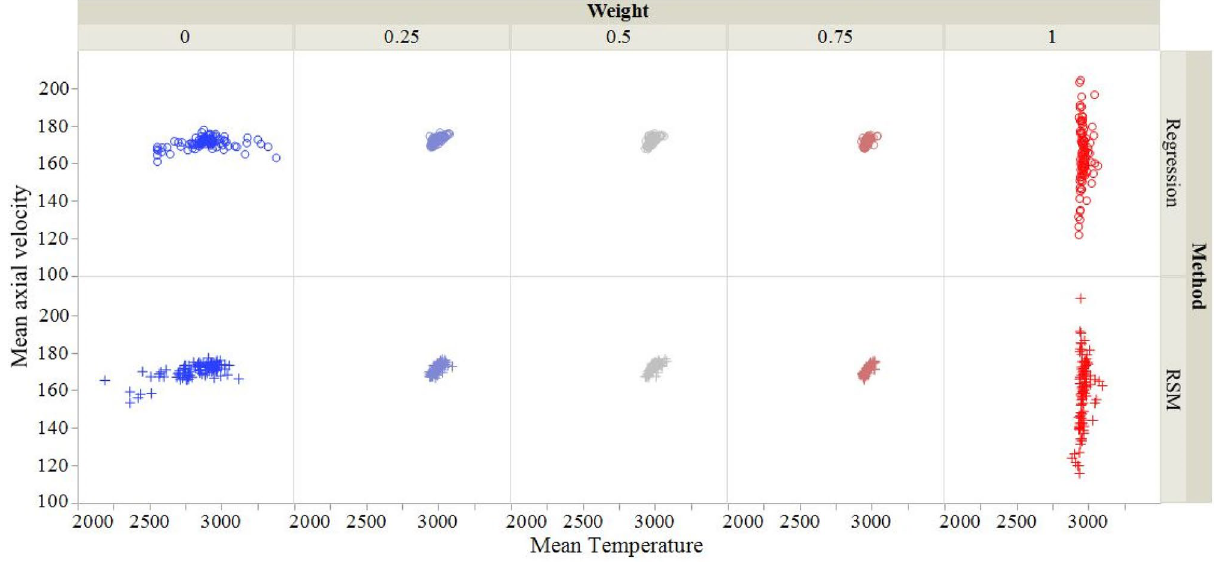
Figure 6. For w = 0, 0.25, 0.5, 0.75 and 1, distributions of the 100 optimal solutions from the RA and the RSM models. It is clear that for w = 0 (1), the mean axial velocity (mean temperature) is essentially unchanged for the 100 solutions. For w = 0.25, 0.5 and 0.75, the solutions are clustered together.